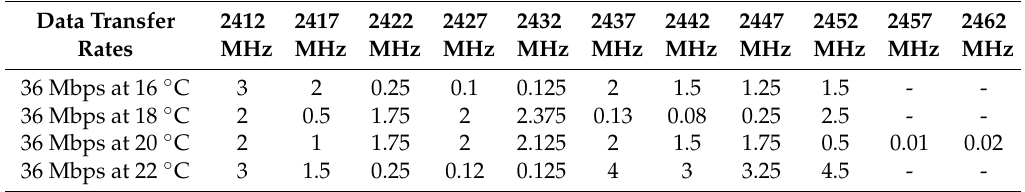
Table 17. Calculation of residuals for OFDM at 36